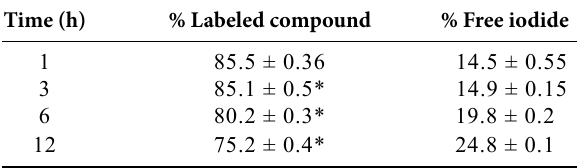
Table 5. Effect of pH on the radiochemical yield of 125 I- TP 5 pH value % Labeled compound